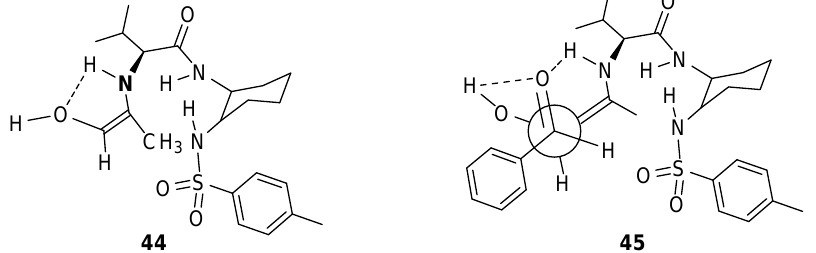
Figure 10. Stable conformers 44 and 45 through which a syn-aldol product was formed.